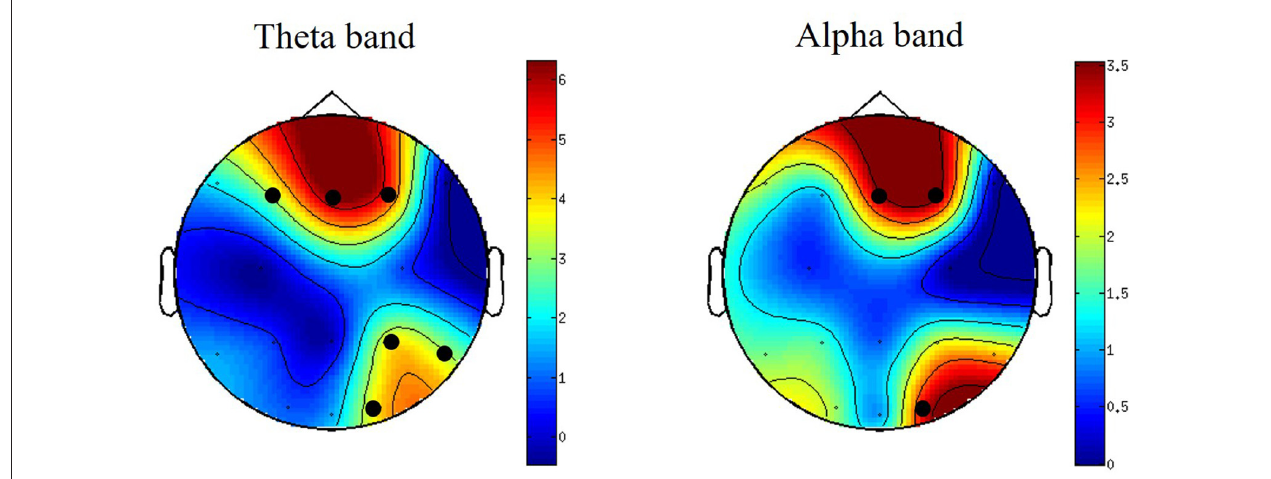
FIGURE 2 | Topographically distributed independent-samples t -values for theta- and alpha-band power differences when watching S vs. N-S videos. For graphical purposes, the surface in between electrodes is interpolated to create scalp maps. Clusters with significant t -values are indicated by black circles. The colors bars indicate the t -values of the clusters. N = 23.